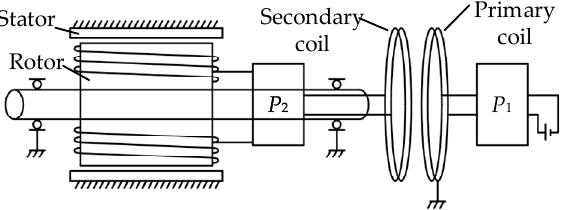
Figure 2. A resonant wireless excitation system of the electrically excited synchronous motor (EESM).